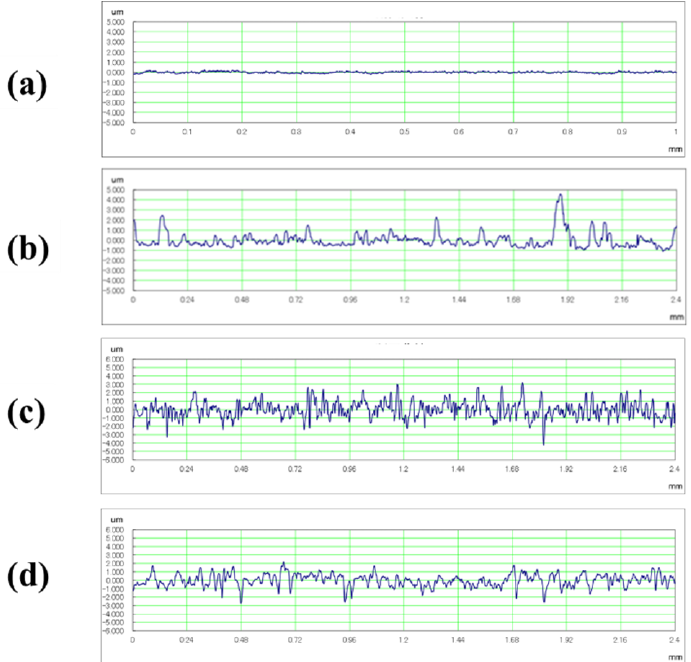
Figure 5. The cross-sectional curves before blasting and after 10 s blasting of each particle are shown: ( a ) before blasting, ( b ) after blasting of β -TCP, ( c ) after blasting of WA particle, ( d ) after blasting of CaCO 3 particle. It can be confirmed that the surface of all particles was greatly roughened.